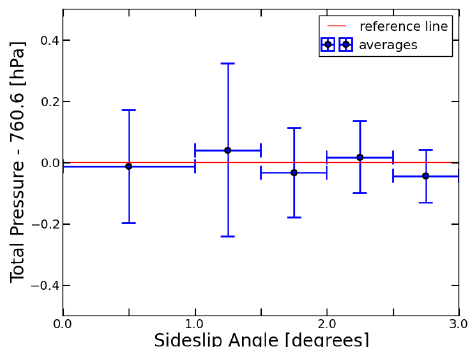
Figure 4. The total pressure (from the sum of the ambient pressure measurement and the dynamic pressure measurement) on the C-130 as a function of the magnitude of the side-slip angle during yaw manoeuvres in which side-slip angles were forced by rudder action while the aircraft continued on approximately a straight-and-level course. The mean total pressure of 760.6hPa has been subtracted from the measurements. Error bars are standard deviations in the measurements for the total pressure axis and are the range of the bin used in side-slip. Corrections for deviations from a level course and for small variations in airspeed have been applied, as discussed in the